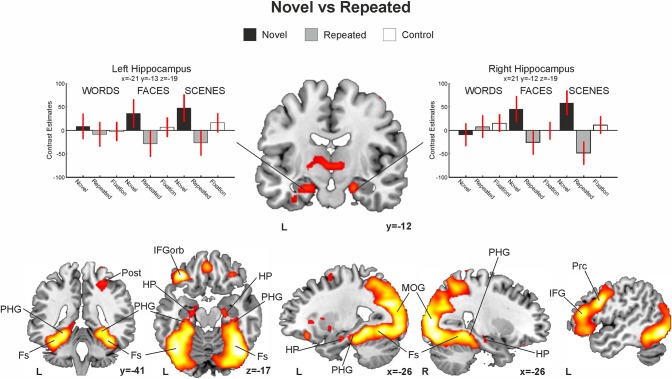
Whole brain novelty contrast.In red-yellow, enhanced group-level fMRI-signal for the Novel > Repeated encoding trials for all three stimuli pooled together (words, faces, scenes). Bar graphs on the right indicate contrast estimates (proportional to percent signal change) with 90% confidence intervals for the maximum peak in the left and right hippocampus (black for novel, grey for repeated, white for fixation). Neurological convention is used. All statistical maps are thresholded at p < 0.05 FDR-corrected with 50 voxels of cluster extent and overlaid over a canonical template with MNI coordinates at the bottom right of each slice. HP, hippocampus; PHG, parahippocampal gyrus; Fs, fusiform gyrus; Post, postcentral gyrus; IFGorb, inferior frontal gyrus pars orbitalis; MOG, middle occipital gyrus; Prc, precentral gyrus; IFG, inferior frontal gyrus; ITG, inferior temporal gyrus; L, Left Hemisphere; R, Right Hemisphere.